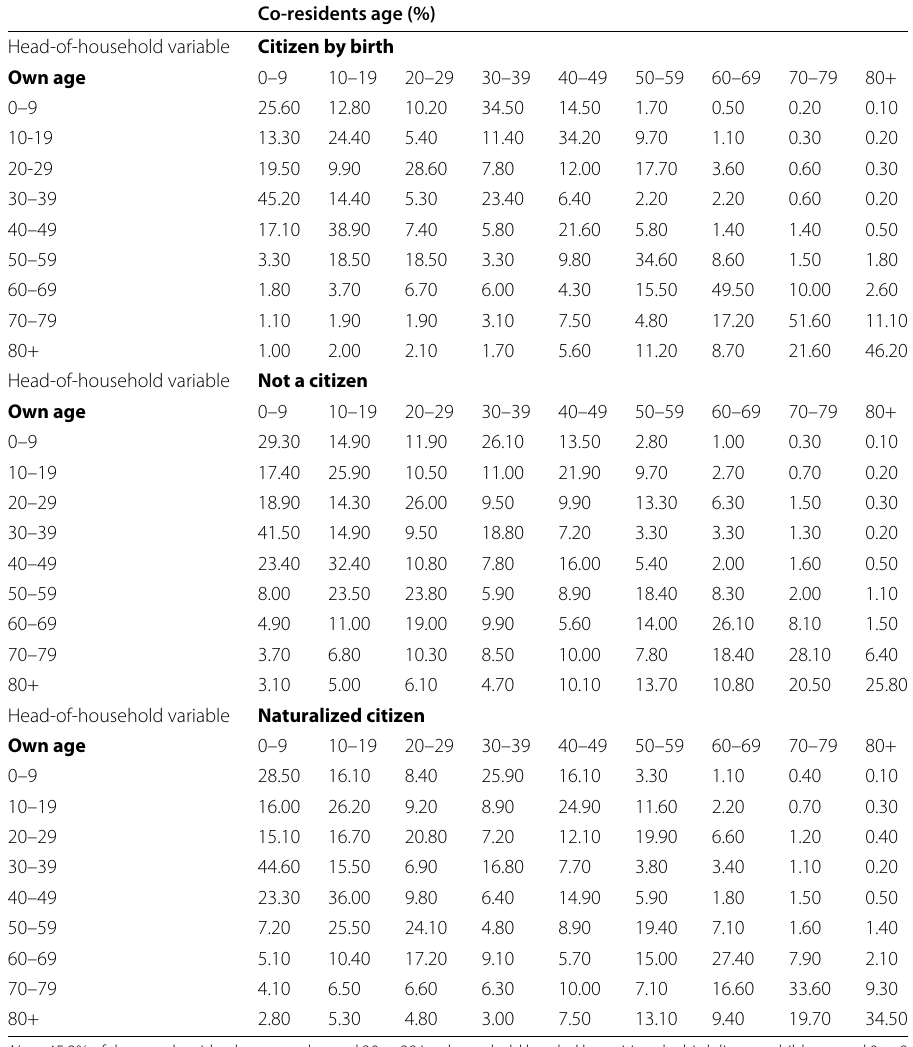
Table 7 Share of co-residents members by age and head-of-household citizenship status Co-residents age (%) Head-of-household variable